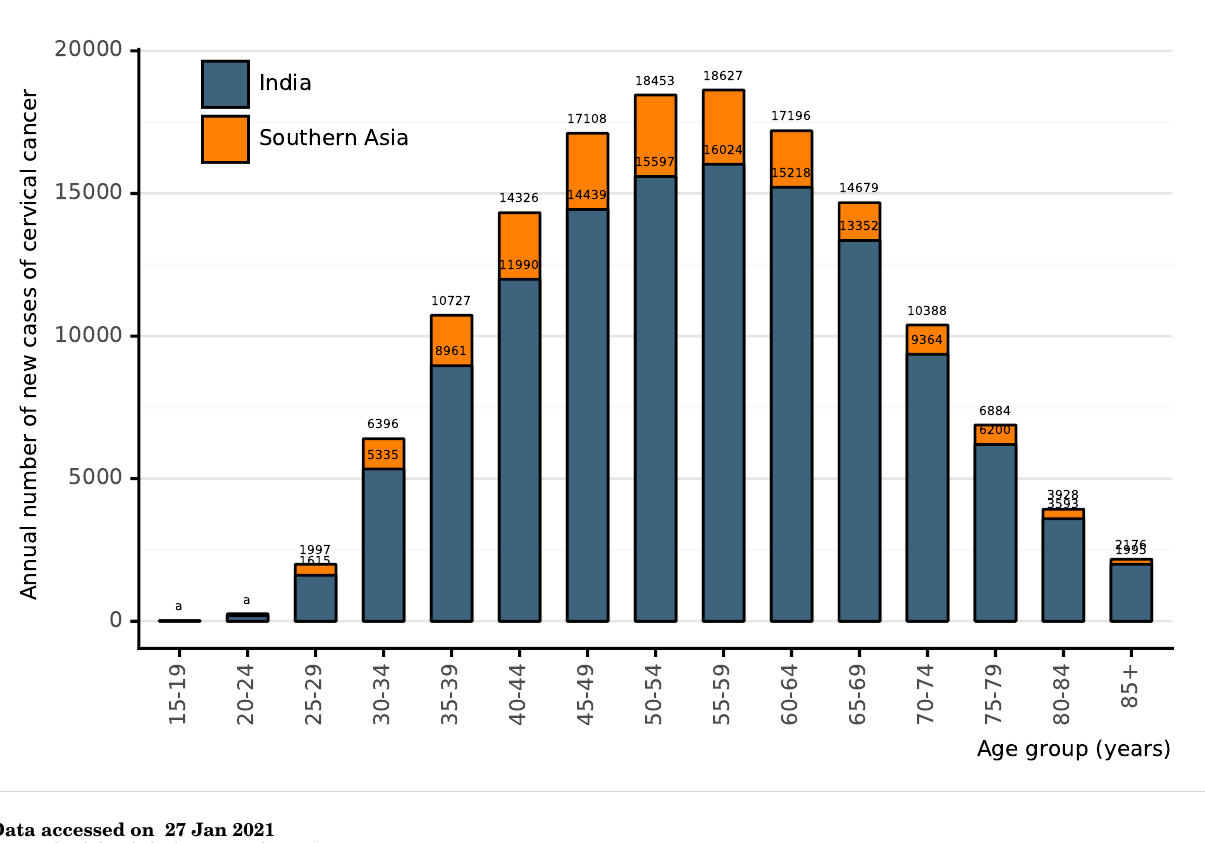
Figure 74: Annual number of new cases of cervical cancer by age group in India (estimates for